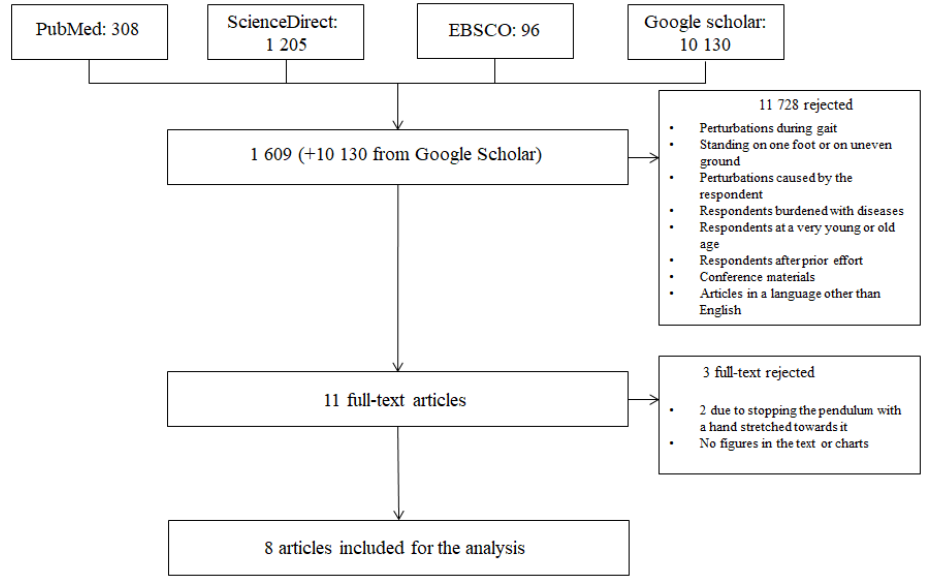
Figure 1. Flowchart demonstrating the selection of articles through the review process.